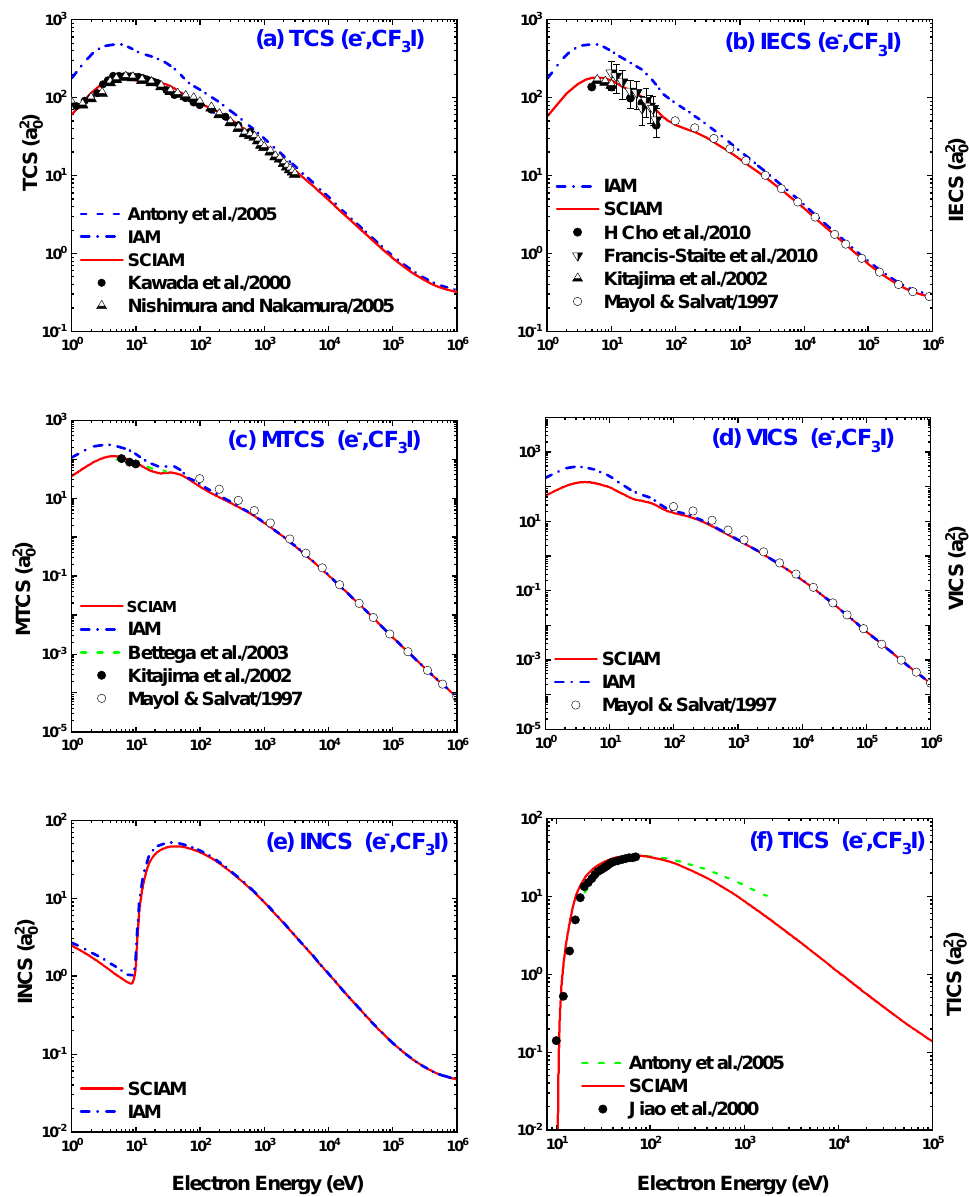
Figure 10. ( a ) TCS, ( b ) IECS, ( c ) MTCS, ( d ) VICS, ( e ) INCS, and ( f ) TICS for the scattering of electrons from CH 3 I. Theoretical works: IAM, SCIAM, Antony et al. [7], Bettega et al. [30], and Mayol